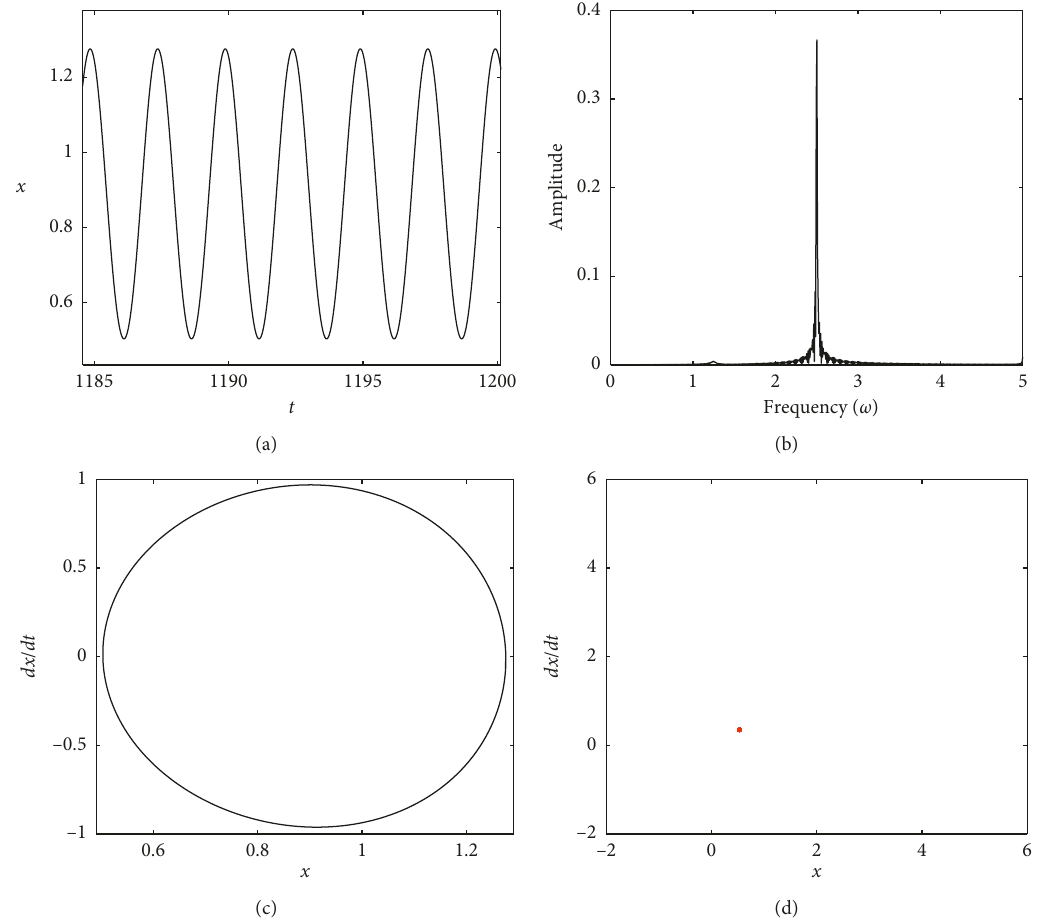
Figure 10: System response at ω � 2.5rad/s and F � 1.75N: (a) time history; (b) frequency spectrogram; (c) phase portrait; (d) Poincare